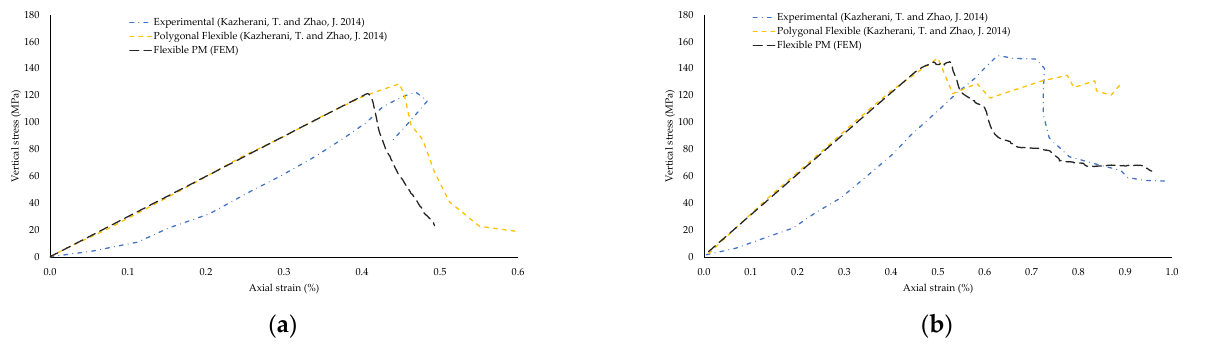
Figure 15. Axial stress-axial strain response under different confinement pressures numerical and experimental response adapted from [15] and proposed calibrated FEM base PM model: ( a ) uniaxial compression; ( b ) 4 MPa confinement.